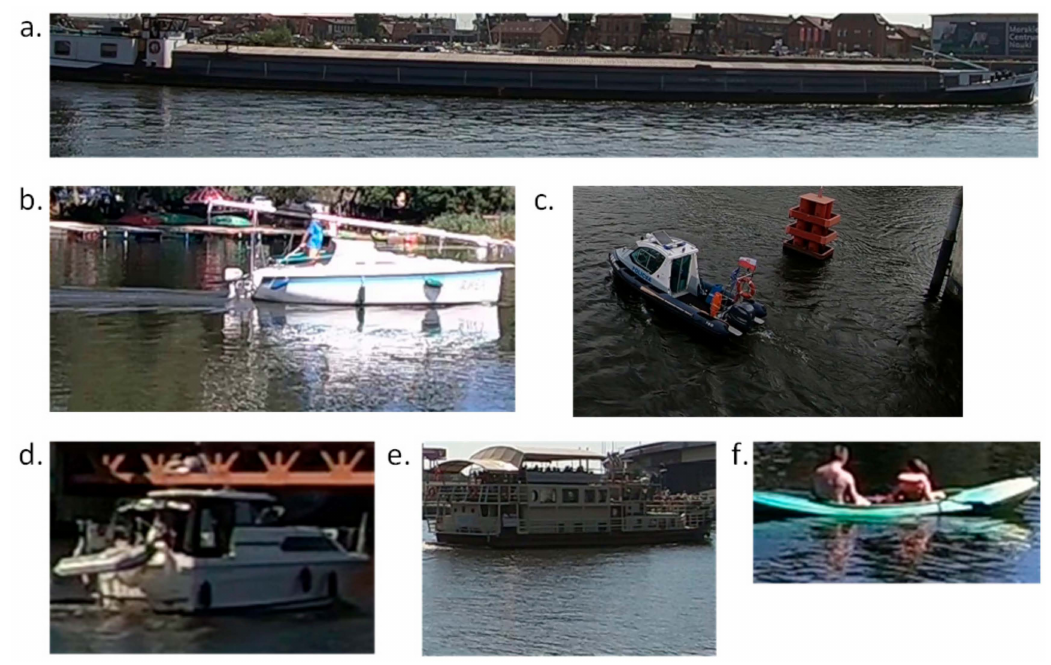
Figure 8. Sample examples of images: ( a ) barge; ( b ) yacht; ( c ) marine service; ( d ) motorboat; ( e ) passenger; and ( f ) other.